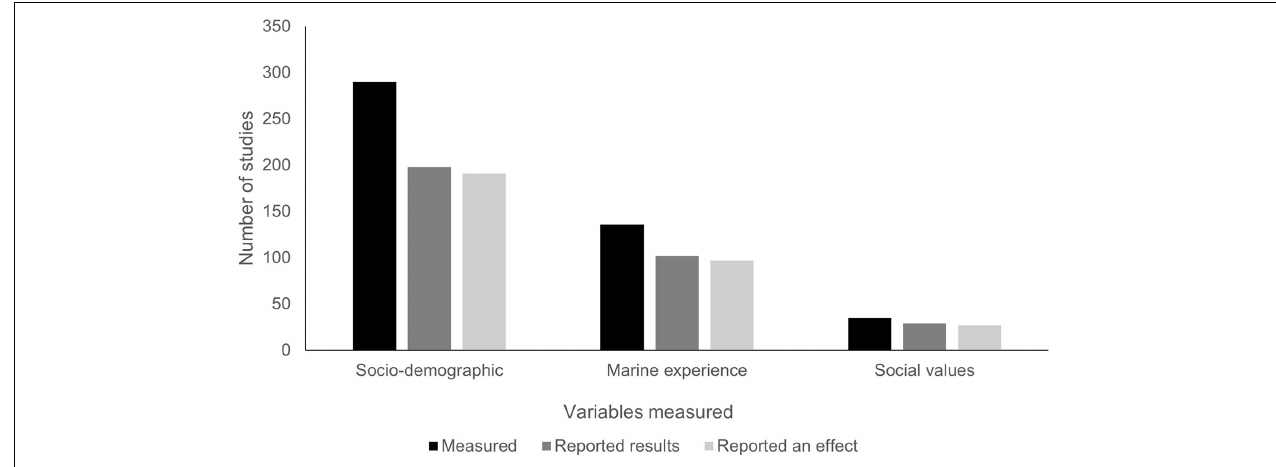
FIGURE 6 | Number of ocean perceptions studies which measured, reported results, and reported effects of socio-demographic variables, ocean experience and social values ( n =